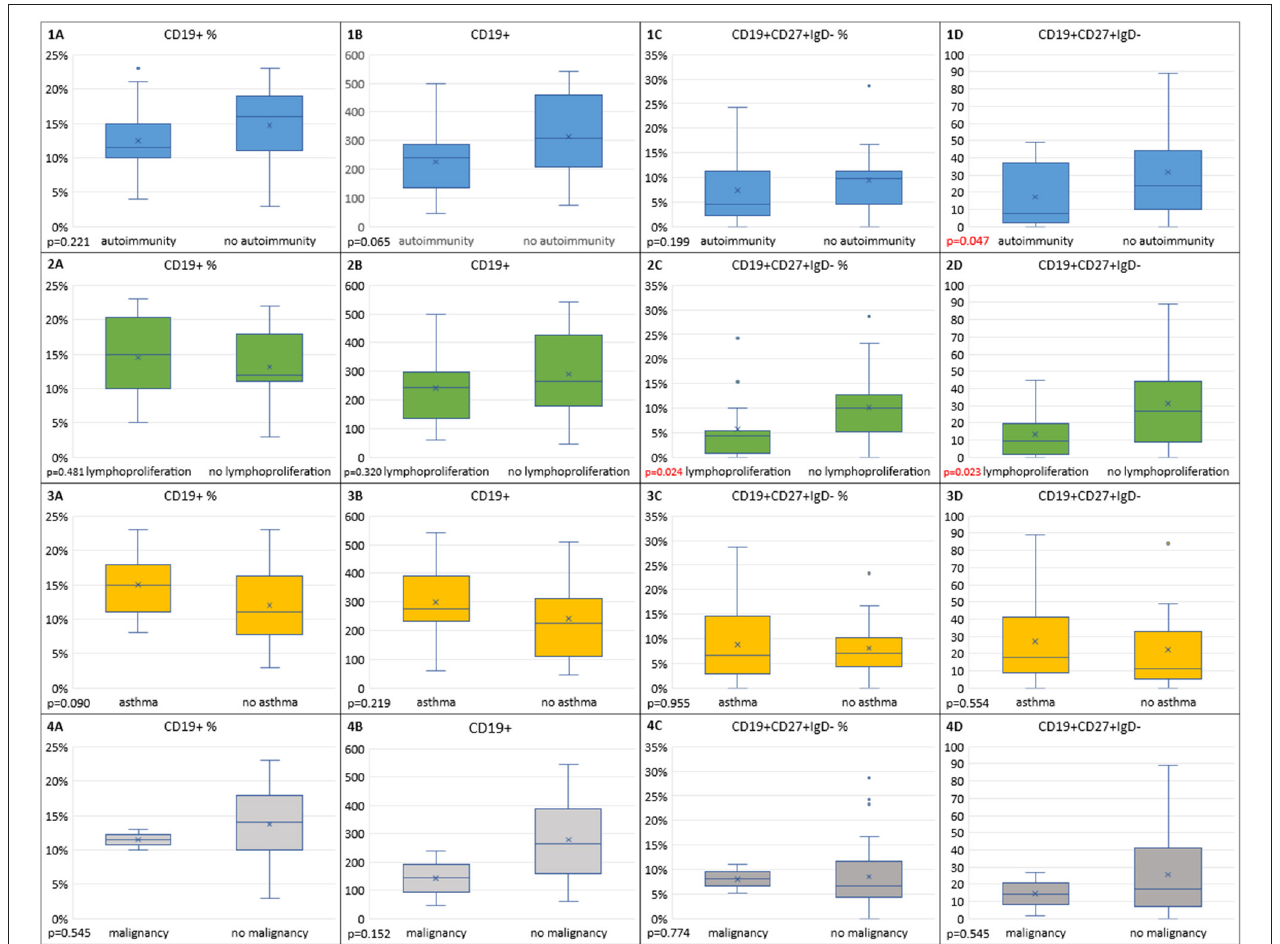
FIGURE 4 | Box plots reflecting distributions of out-of-range relative values (A,C) and absolute counts (B,D) of total B cells and switched memory B cells in immune dysregulation vs. no dysregulation groups. (1) Autoimmunity vs. no autoimmunity ( n = 18 vs. n = 21, respectively); (2) Lymphoproliferation vs. no lymphoproliferation ( n = 14 vs. n = 25); (3) Asthma vs. no asthma ( n = 21 vs. n = 18); and (4) Malignancy vs. no malignancy ( n = 2 vs. n =